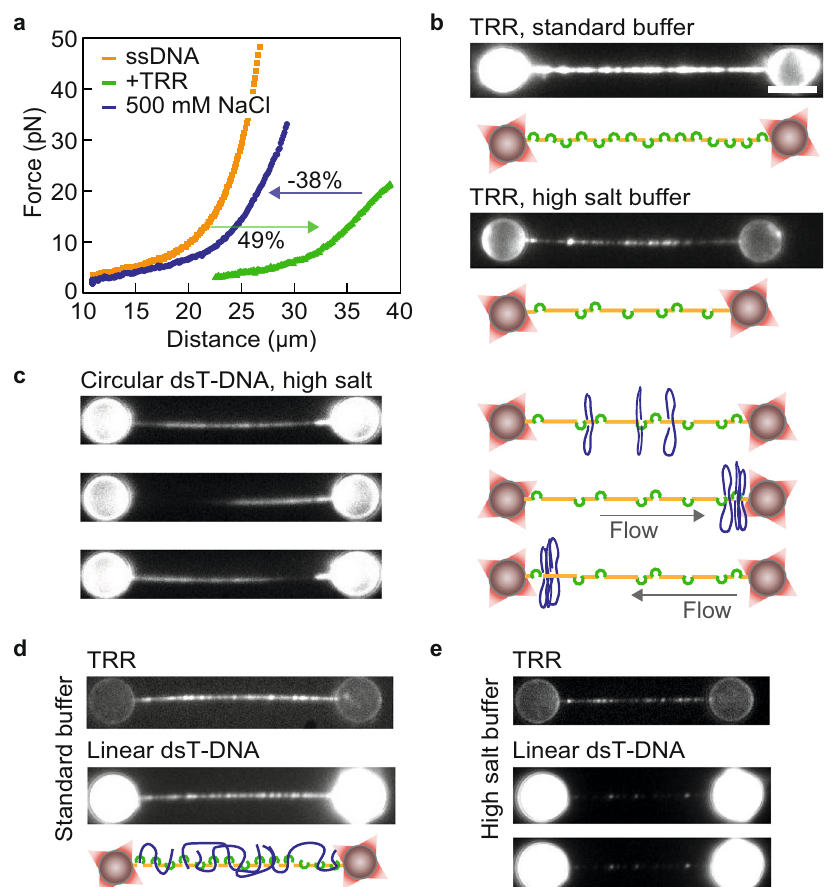
Fig. 4 Catenation of circular dsDNA around tethered ssDNA by TRR. a Representative FD-curves (from N ≥ 20) of TRR-ssDNA before (green) and after (blue) incubation in high-salt buffer. For reference, the FD-curve of bare ssDNA is shown in orange. Arrows depict the changes in end-to-end distance: TRR binding in standard buffer results in ~49% lengthening of the ssDNA, which was reversed by ~ − 38% after moving the substrate into high-salt buffer due to TRR unbinding. b Representative mCherry fl uorescence images (from N ≥ 20) of TRR-ssDNA before (top) and after (bottom) incubation in high-salt buffer. The scale bar represents 5 µ m, and applies to all snapshots. c Representative intercalator fl uorescence images (left; from N ≥ 10) and schematic representations (right) of circular dsT-DNA catenated around tethered TRR-ssDNA after incubation in high-salt buffer under different buffer fl ow conditions. The applied fl ow helps visualize the high mobility of the dsT-DNA. d Representative fl uorescence images (from N = 3) of TRR-ssDNA (mCherry fl uorescence, top) bound by linear dsT-DNA (intercalator staining, centre), recorded in standard buffer. A schematic representation of the interaction is also shown (bottom). e Representative fl uorescence images (from N = 3) of TRR-ssDNA (mCherry fl uorescence, top) bound by residual linear dsT-DNA (intercalator staining, bottom two images), recorded in high-salt buffer (same molecule as in panel ( d )). The two bottom images were obtained several seconds apart and show a similar (albeit weak) fl uorescence intensity pattern, suggesting that the dsT-DNA was bound to residual TRR that remained on the ssDNA. Note that when incubating in high-salt buffer, the tension was reduced to <1 pN in order promote protein unbinding. Source data are provided as a Source Data fi (Fig. 5g and Supplementary Data 4). Similar to the case for TRR- af fi nity for Ec TopoI-ssDNA than for TRR-ssDNA. Correspond- curve (Fig. 5e). Taken together, these fi ndings suggest that, while